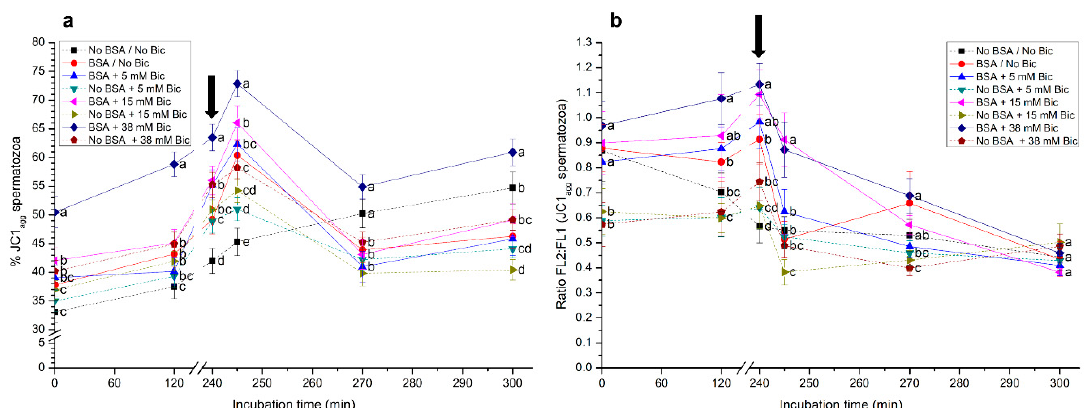
Figure 5. ( a ) Percentages of sperm with high mitochondrial membrane potential (MMP; JC1 agg ), and ( b ) FL2:FL1 (or- ange:green) ratios in the sperm population with high MMP (JC1 agg ) following incubation with different concentrations of bicarbonate (Bic; 0 mM, 5 mM, 15 mM, 38 mM) and BSA (0, 5 mg/mL) for 300 min. The black arrow indicates the time at which 10 µ g/mL of progesterone was added (i.e., 240 min) to induce acrosome exocytosis. Different superscripts (a–d) indicate significant differences ( p < 0.05) between treatments within the same time point. Data are shown as mean ± SEM for 12 independent experiments.